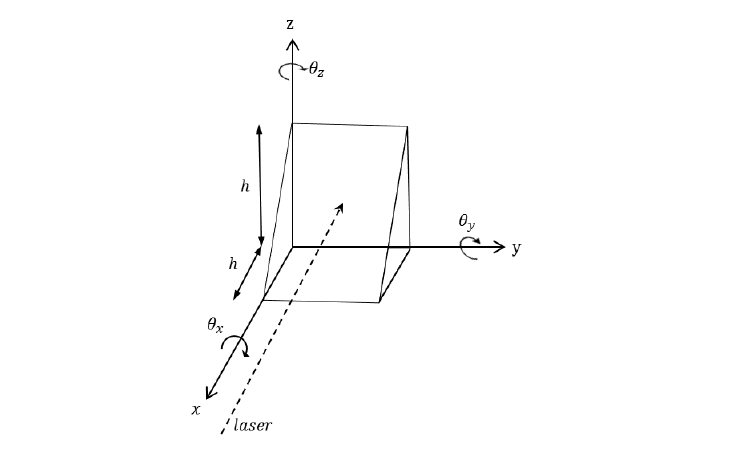
Figure 14. Variations in the measured value according to the rotation of the triangle